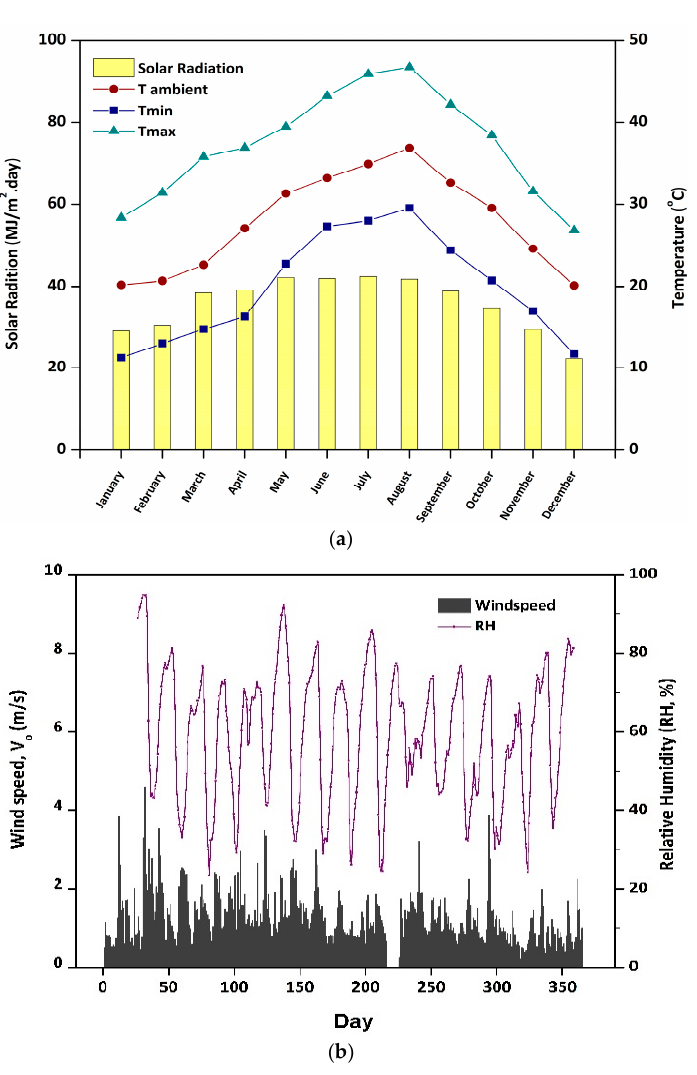
Figure 9. Weather charts for the location of the test site in Ras Al Khaimah, UAE. ( a ) Radiation and temperatures. ( b ) Wind speed and relative humidity.